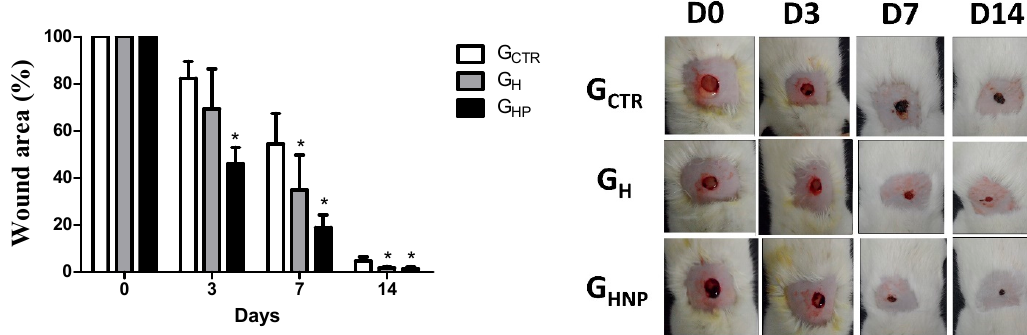
Figure 6. Non-splinted model showing the percentage of the non-epithelialized surface of the wound of the groups: G CTR (Control Group), G H (Group with hydrogel sodium alginate / gelatin (80:20), and G HP (Group hydrogel with AgNP 4 mM AgNO 3 ). All values are mean ± S.E. Statistical analysis comprised by ANOVA followed by Tukey’s test. * p < 0.05 in relation to G CTR , G H , and G HP groups, respectively ( n = 21/group).